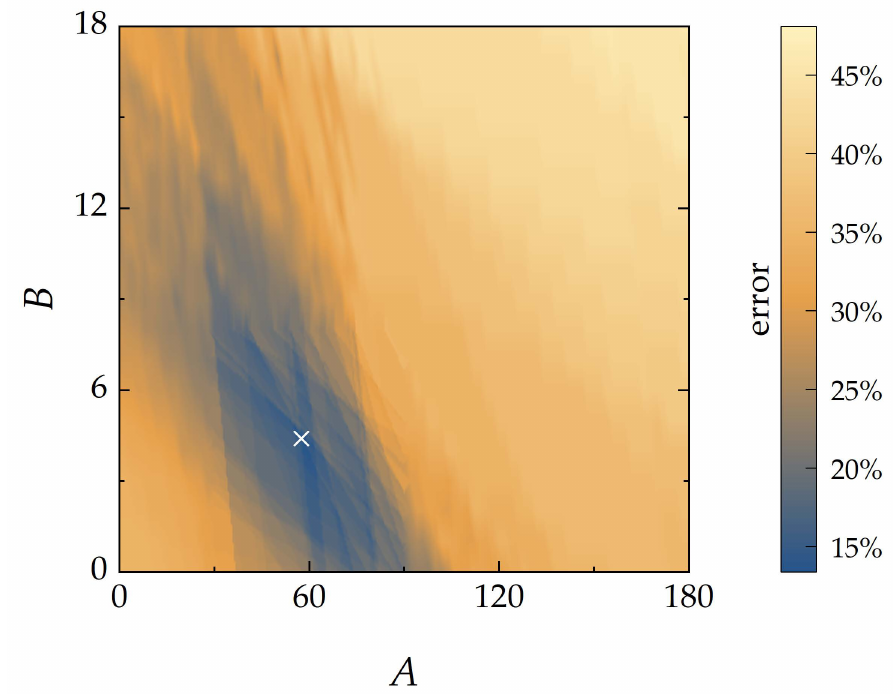
Figure 5. Distribution of the average separation error of the crater model with viscous dissipation of energy (Equation (9)) at different constants A and B . The white cross shows the constants (57.5; 4.4) at which the error has minimum